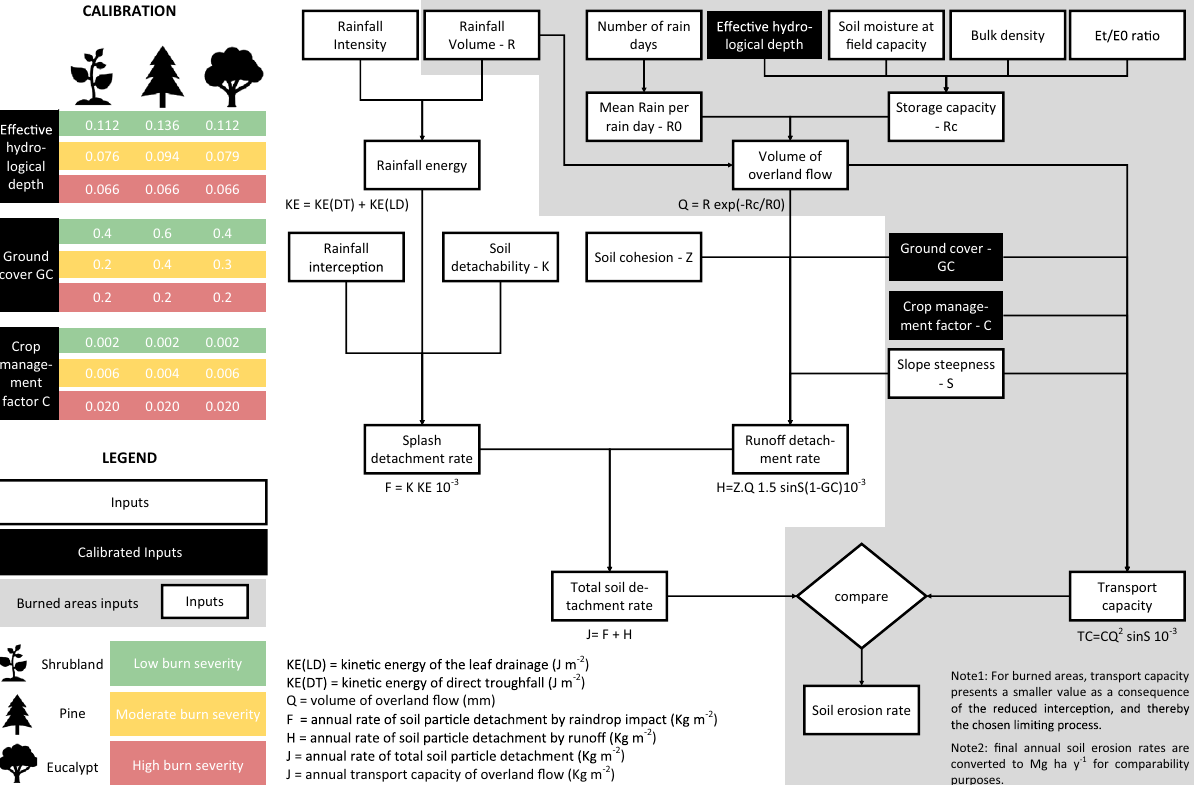
Figure 1. Simplified flow chart of the revised Morgan-Morgan-Finney model, showing the key equations for the different model phases and the parameterization data for different land covers and classes of burn